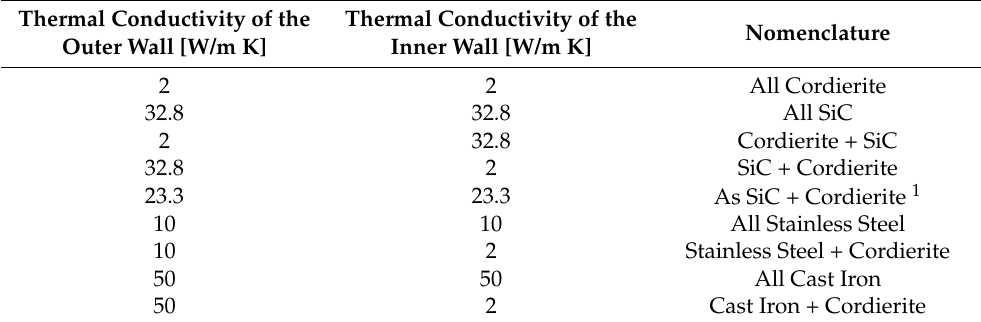
Table 3. Values of thermal conductivity for the outer and inner walls adopted in the computations. Thermal Conductivity of the Thermal Conductivity of the Outer Wall [W/m K] Inner Wall [W/m